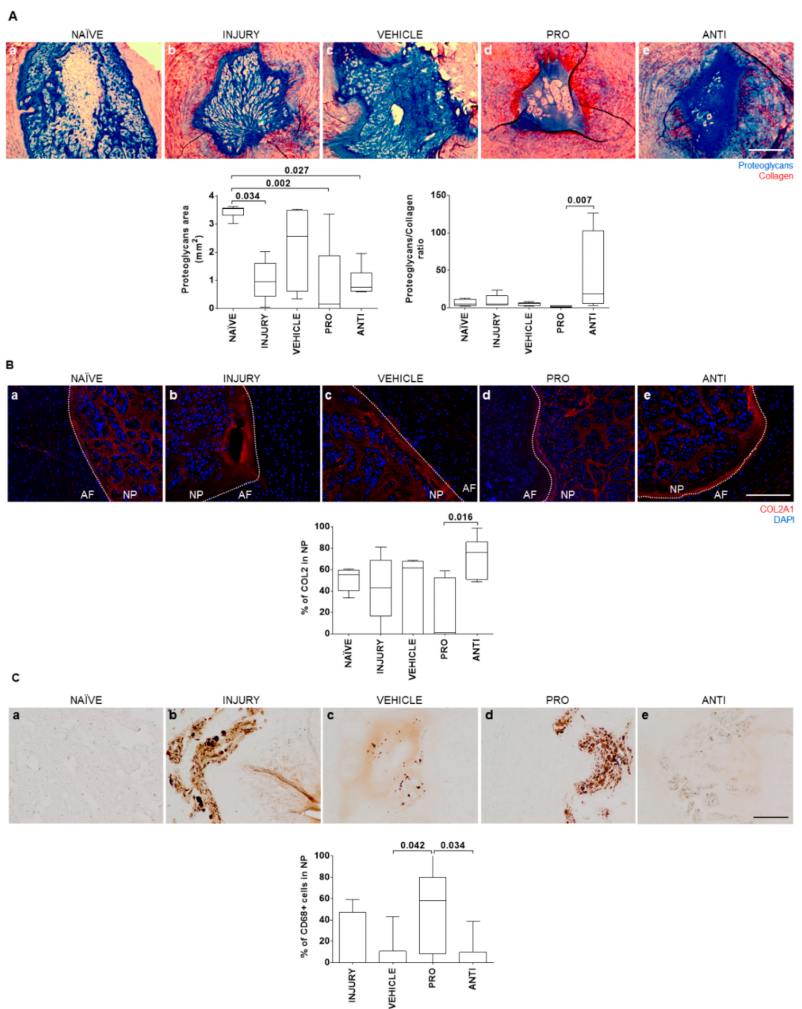
Figure 3. Histopathological analysis of nucleus pulposus (NP) tissue in naive and lesioned IVDs 2 weeks post-injury and intradiscal administrations. ( A ) Representative images of NP extracellular matrix (ECM) by Alcian blue / Picrosirius red staining (proteoglycans in blue and collagen in red; scale bar, 500 µ m); quantification of the proteoglycans area (mm 2 ) and proteoglycans / collagen ratio in the NP. ( B ) Representative images of collagen type II (COL2) staining in the NP for all groups (COL2 is stained in red and DAPI stains cell nuclei in blue; scale bar, 200 µ m); percentage of COL2 area in the NP. ( C ) Representative images of macrophages in the NP by CD68 immunostaining for all groups (positive cells are stained in brown; scale bar, 200 µ m); quantification of the percentage of CD68 + cells in the NP. Results are presented in box-and-whisker plots with associated p -value ( n = 6 animals /